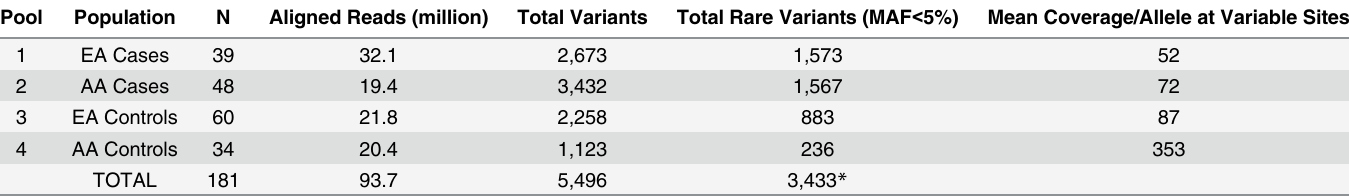
Table 2. Overview of total and rare variants called in anonymous pooled sequencing of coding exons for 131 candidate genes using the SPLINTER algorithm. EA = European American, AA = African American, MAF = minor allele